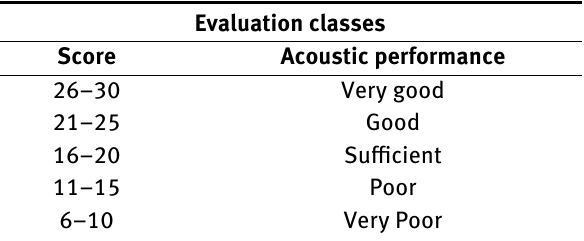
Table 4: Evaluation classes: scores and related